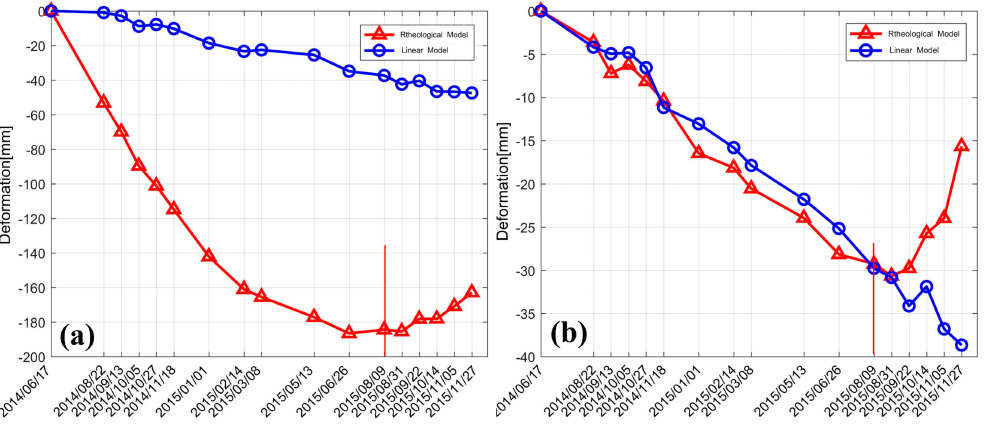
Figure 10. Time-series results on two feature points: ( a ) CT1 and ( b ) CT2 (with reference to 2014 / 6 /